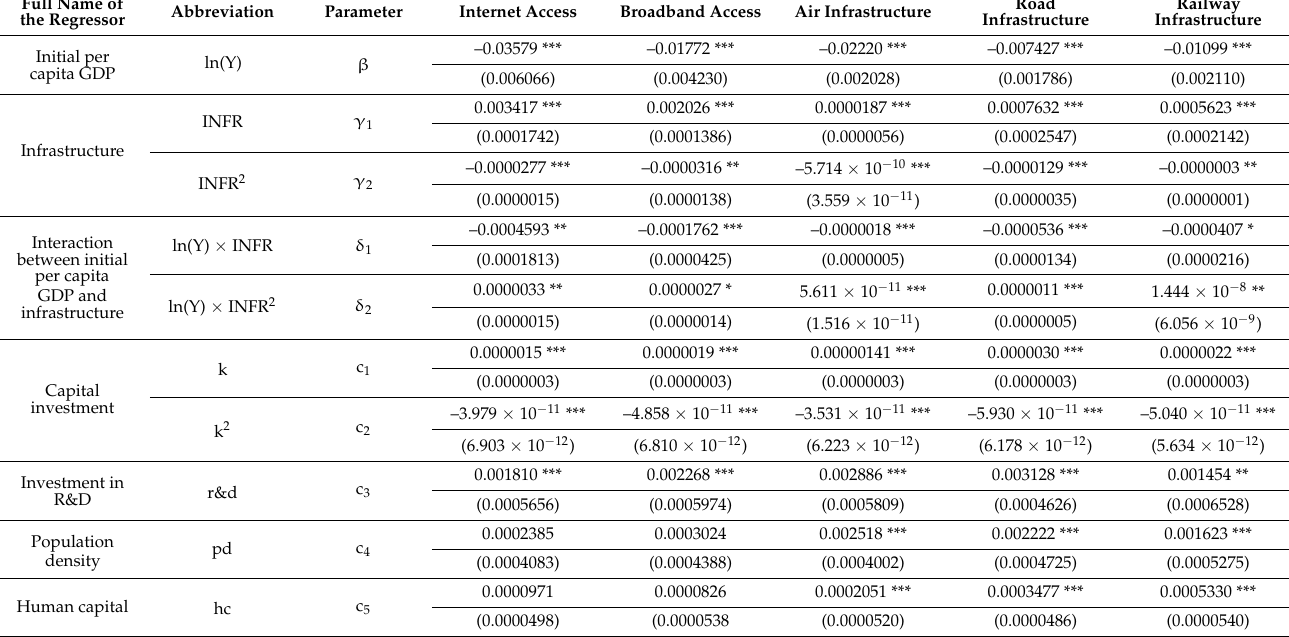
Table 3. Fixed effects estimates of Equation (2). Dependent variable—5-year forward-looking average growth